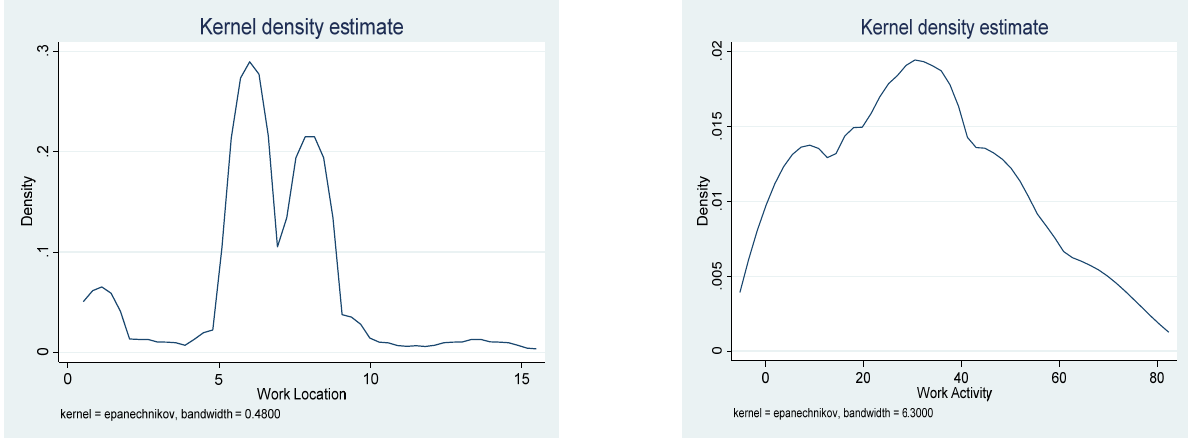
Figure 3. Kernel distribution of main variables used in the empirical analysis. Source: Own data process in Stata.